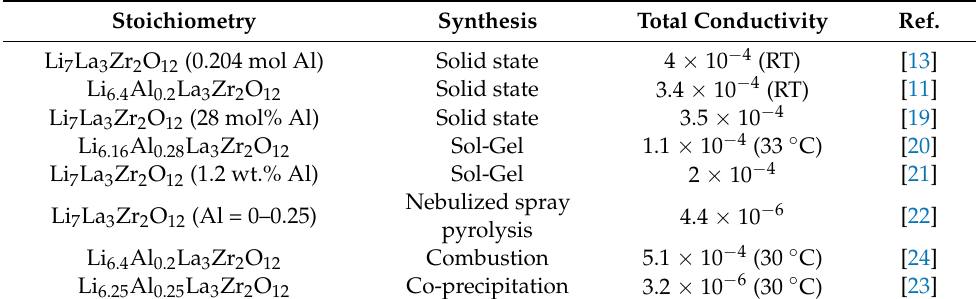
Table 1. Selected literature data to different synthesis methods of